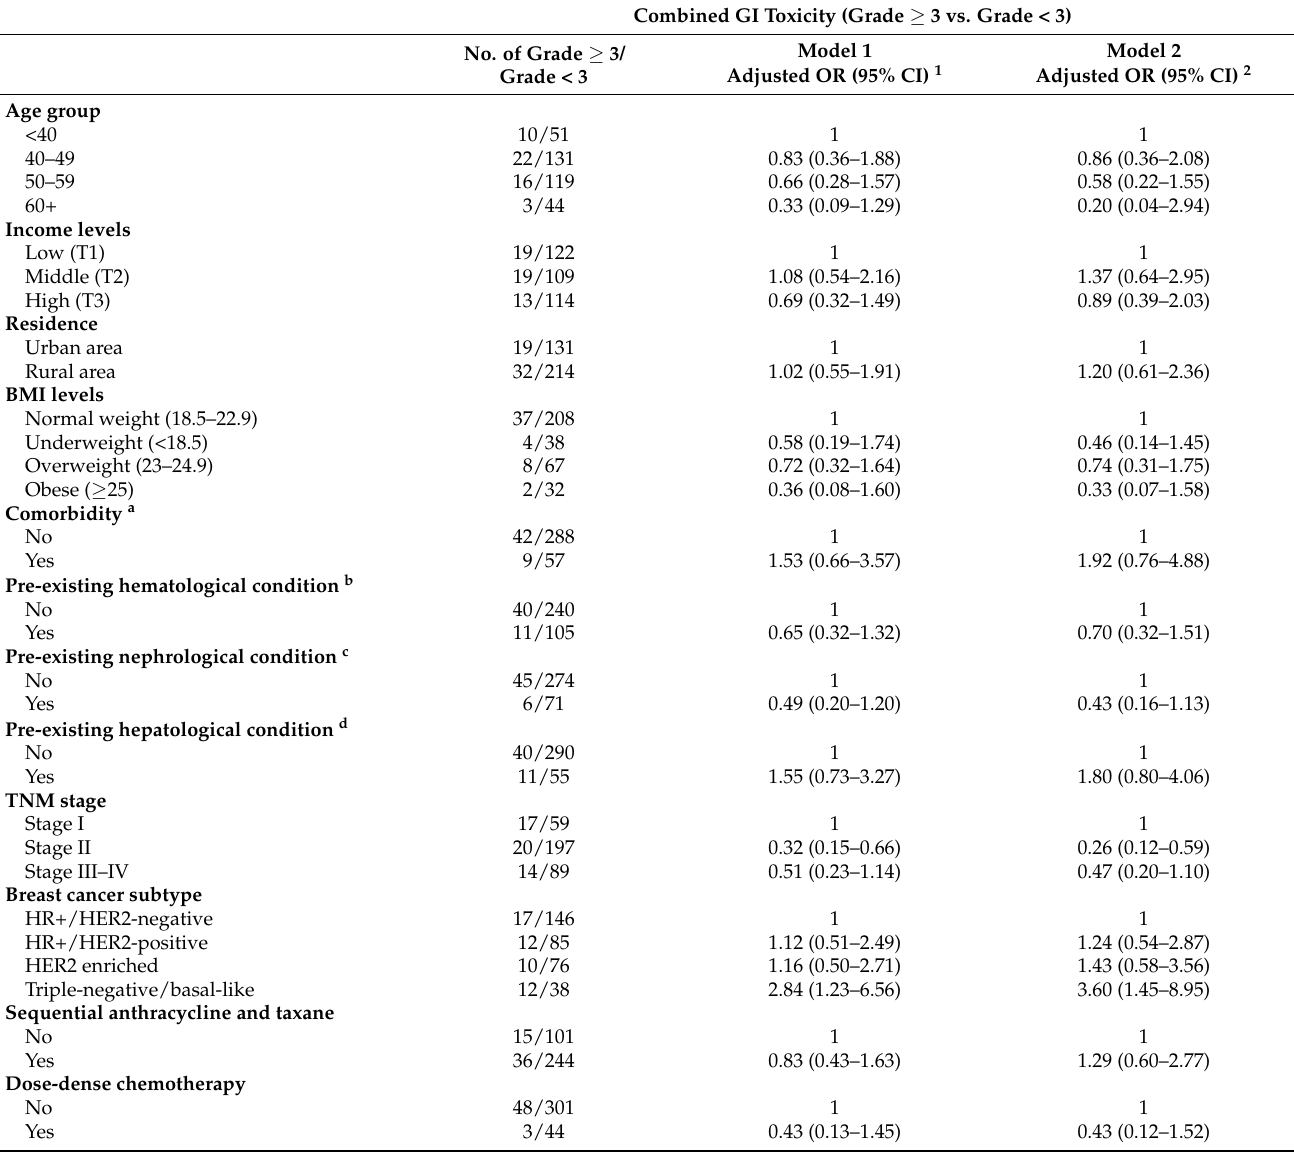
Table 4. Association of demographic characteristics and clinical factors with combined GI